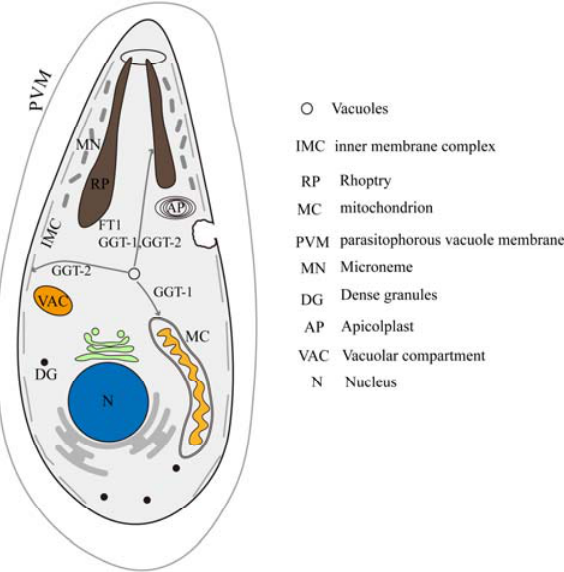
Figure 8. Model of the e ff ects of FT, GGT-1 and GGT-2 on organelles of the parasite. IMC: inner membrane complex; RP: rhoptry; MC: mitochondrion; PVM: parasitophorous vacuole membrane; MN: microneme; DG: dense granules; AP: apicoplast; VAC: vacuolar compartment; N: nucleus.